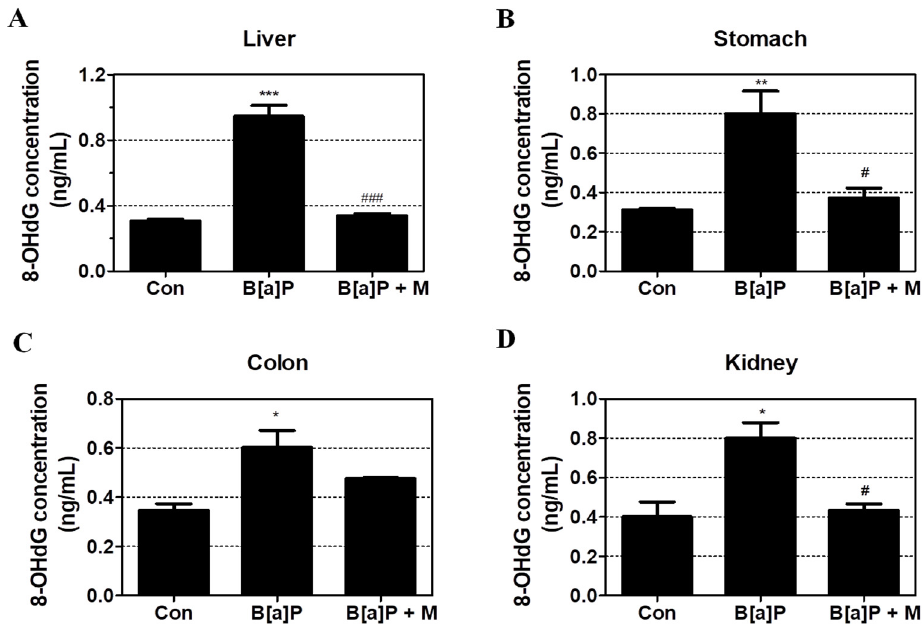
Figure 3. Oxidative DNA damage following B[a]P (2 mg / kg) and myricetin (10 mg / kg) co-treatment. Oxidative DNA damage was measured by the concentration of 8-OHdG in liver, stomach, colon, and kidney tissues. ( A – D ) Myricetin was protective against B[a]P-induced 8-OHdG formation